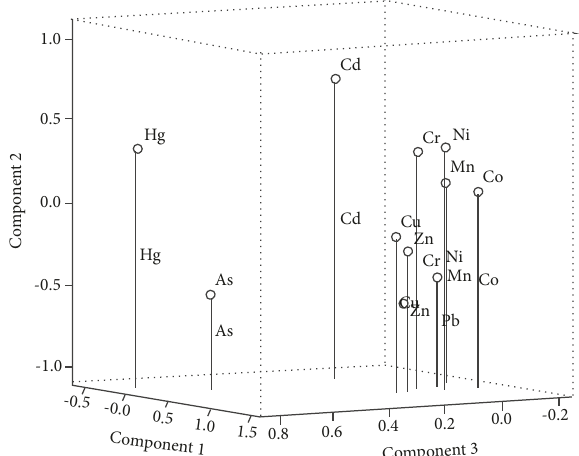
Figure 5: Principal components of the heavy metals in